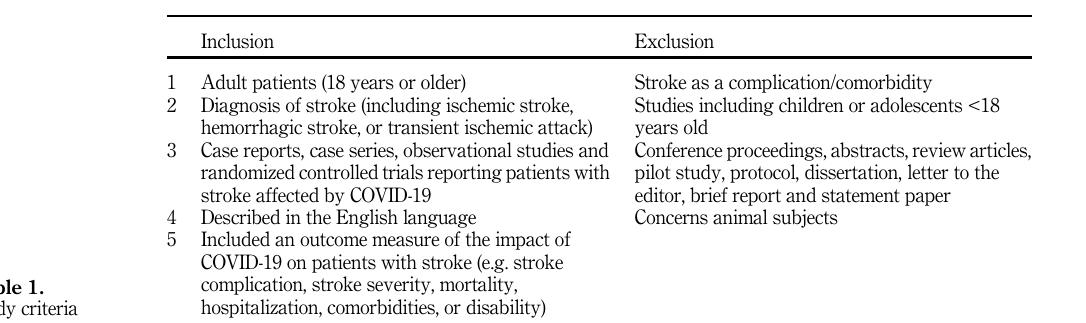
Figure 1. Flow chart diagram displaying the selection method of eligible